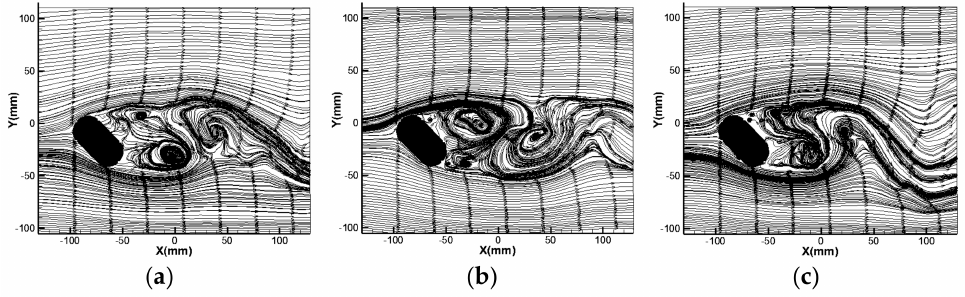
Figure 10. Instantaneous surface flow diagram of flow around a single circular ended pier with α = 45 ◦ . ( a ) T = 0 s; ( b ) T = 0.783 s; ( c ) T = 1.592 s.